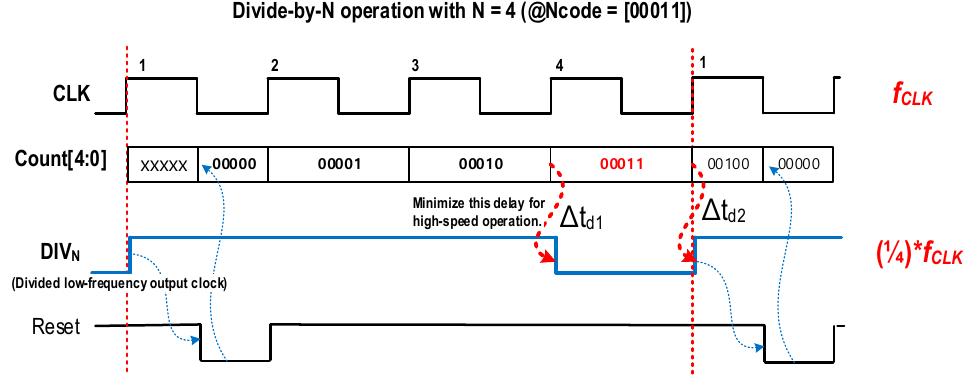
Figure 7. Operation of the proposed programmable divide ‐ by ‐ N divider when N = 4 (Ncode [4:0] = [00011]).